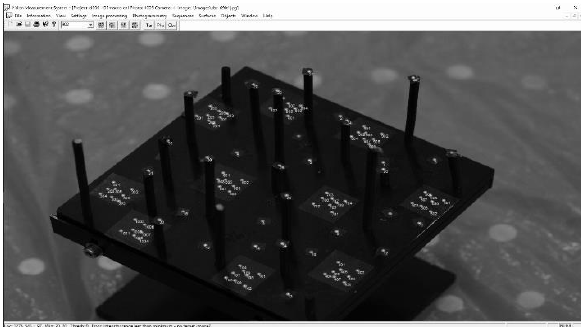
Figure 2. One of a set of convergent calibration images of the miniature Manhattan artefact.